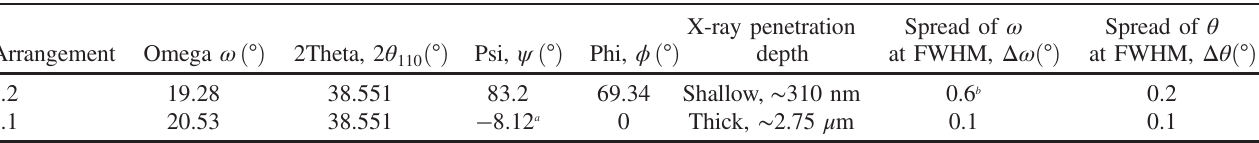
a Minus sign means tilting direction. b Spread of multiple